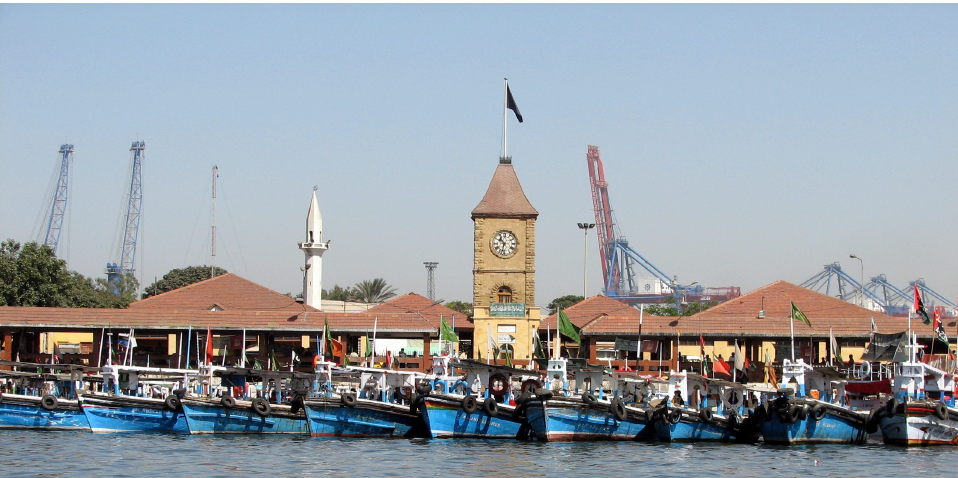
Figure 2. Boat Basin, Passenger Wharf Karachi